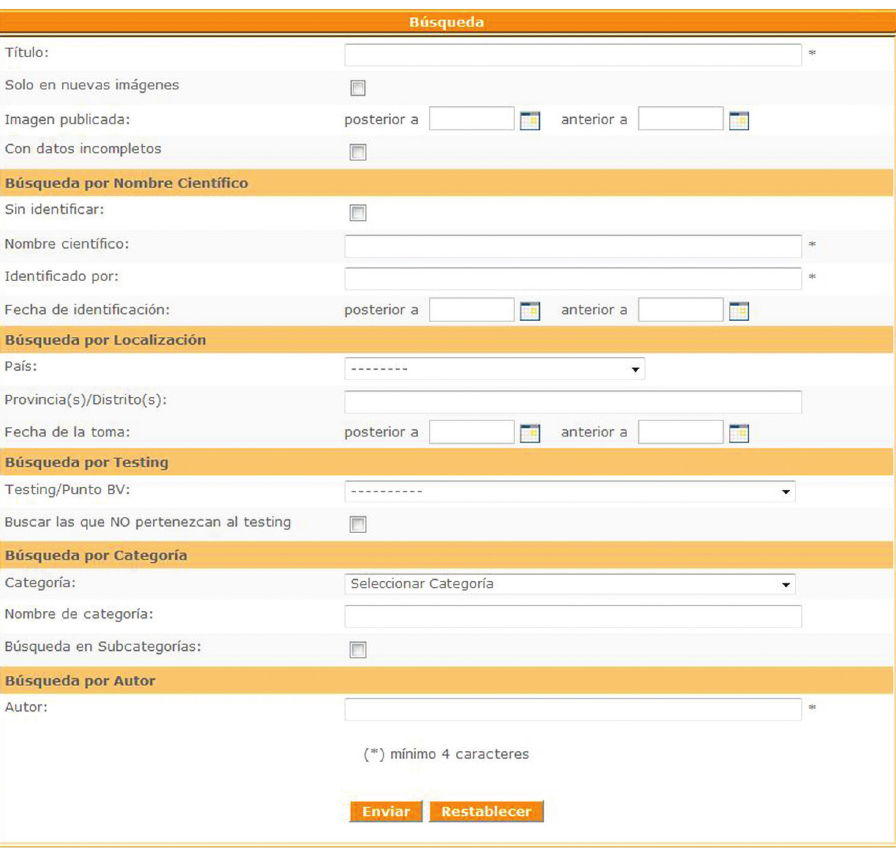
Figure 3. Windows interface implemented in Biodiversidad Virtual internet photosharing website to retrieve information from database